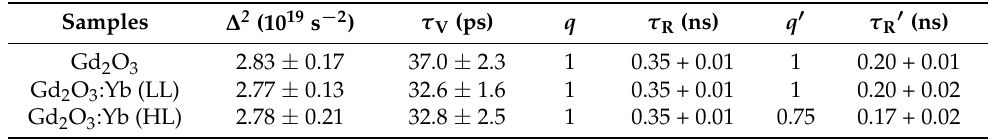
Table 2. Selected best-fit parameters obtained from the analysis of the 1/ T 1 NMRD profiles (310 K) of all the nanoparticles.